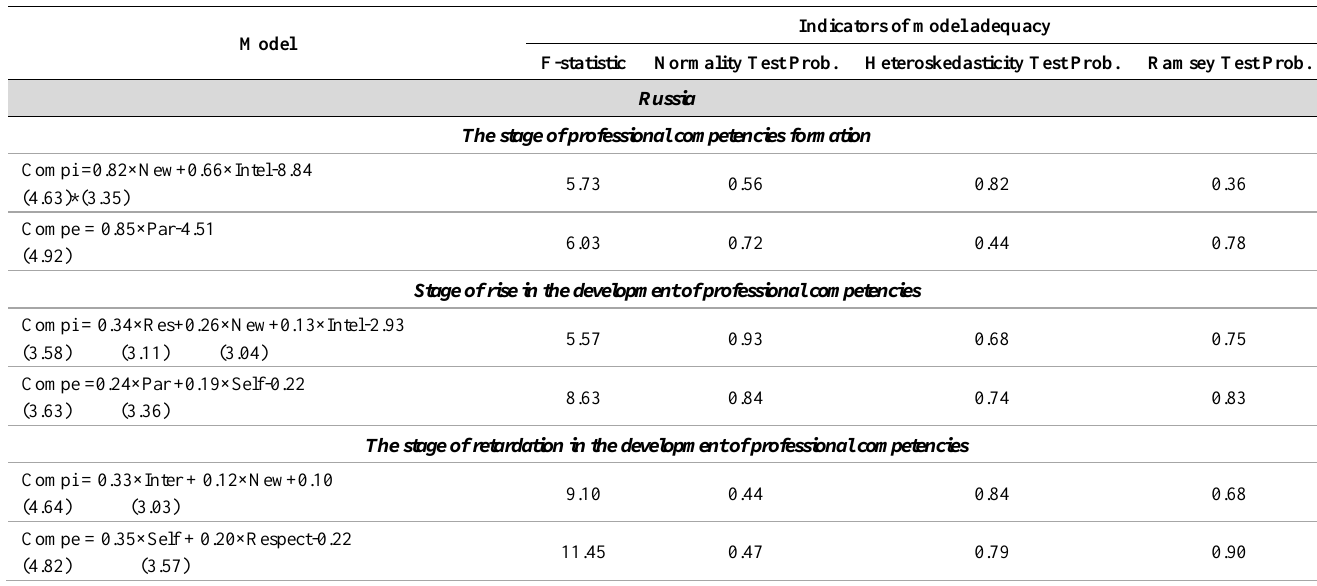
Table 6. Regression models of assessing the influence of motivation factors on the development of professional